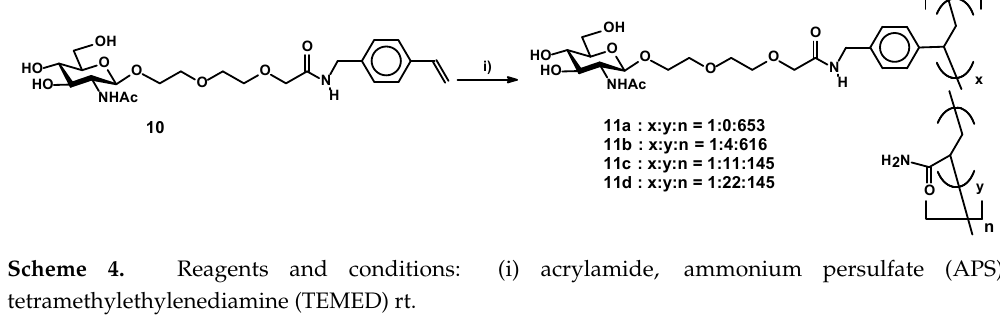
Table 2. Results of polymerizations of NAG-Str 10 with or without acryl amide ( AAm ). Monomer